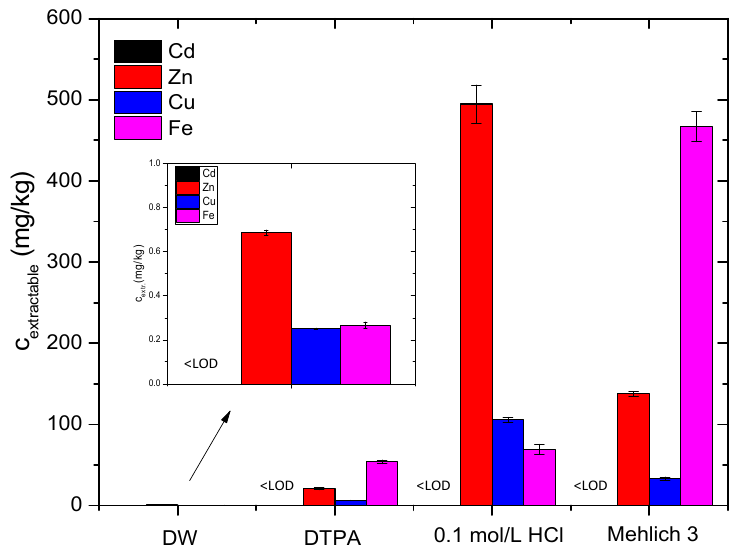
Figure 2. Extractability of Cd, Zn, Cu and Fe (mg/kg) from PM in the one-step protocols using deionized water (DW), diethylenetriaminepentaacetic acid (DTPA), 0.1 mol/L HCl and Mehlich 3 extraction reagents. The values of extractable Cd under the given conditions were lower than the limit of detection for the given concentration determined by the F-AAS method (<limit of detection-LOD).